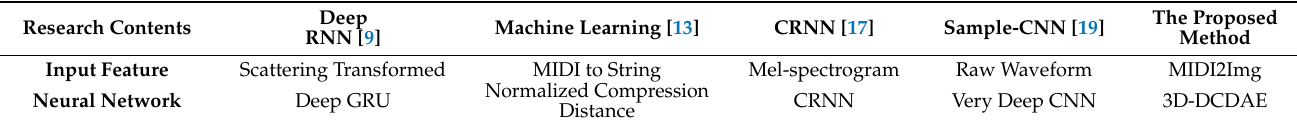
Table 1. Difference between existing methods and the proposed